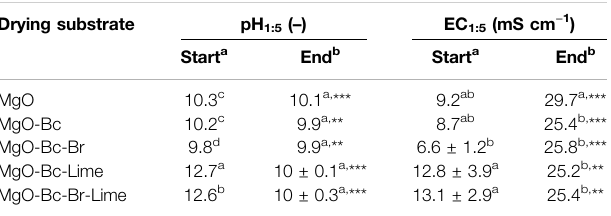
TABLE 5 | pH and EC of the substrates at the start and at the end of the dehydration treatment measured in 1:5 (w/v) substrate: urine suspensions at room temperature (21 ± 2 °